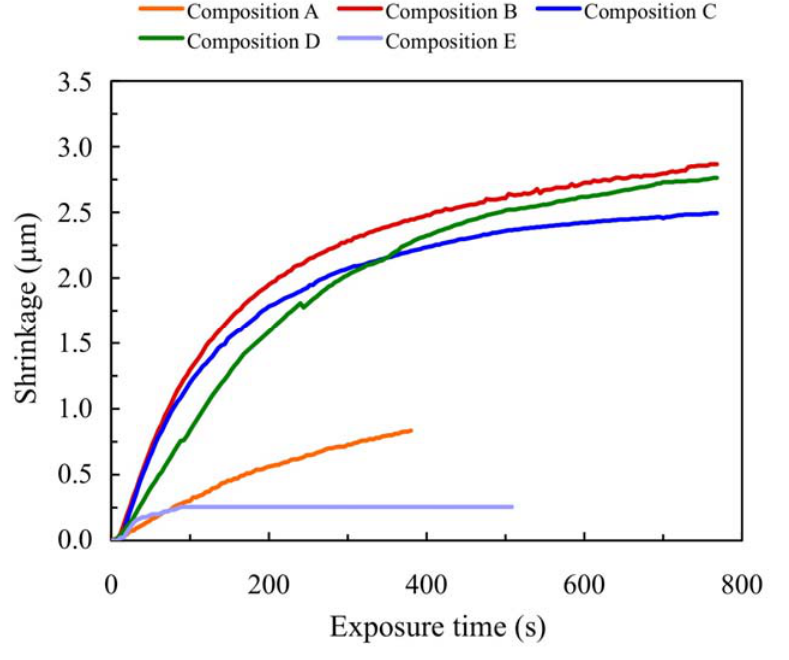
Figure 3. Shrinkage as a function of exposure time for photopolymer compositions A, B, C, D, and E in reflection